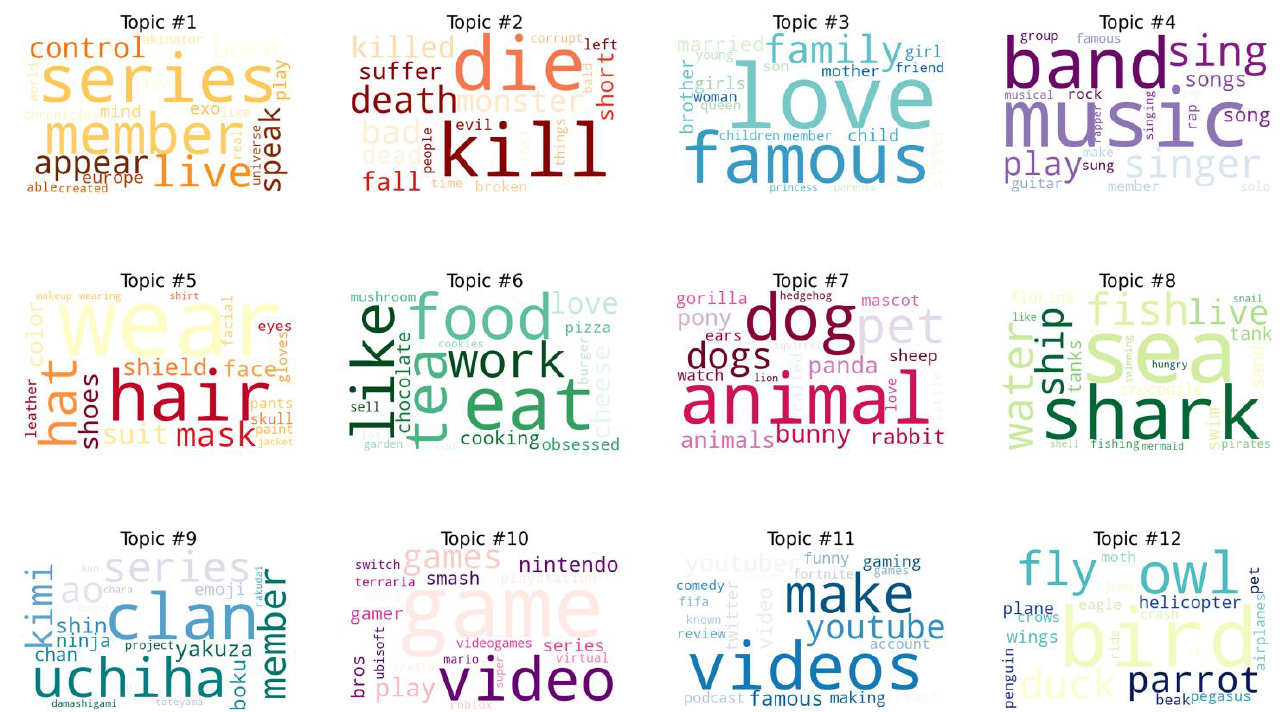
Figure 4. The 20 highest weighted words in each of the largest topics created by the BERT model. In total, 44 topics were created.